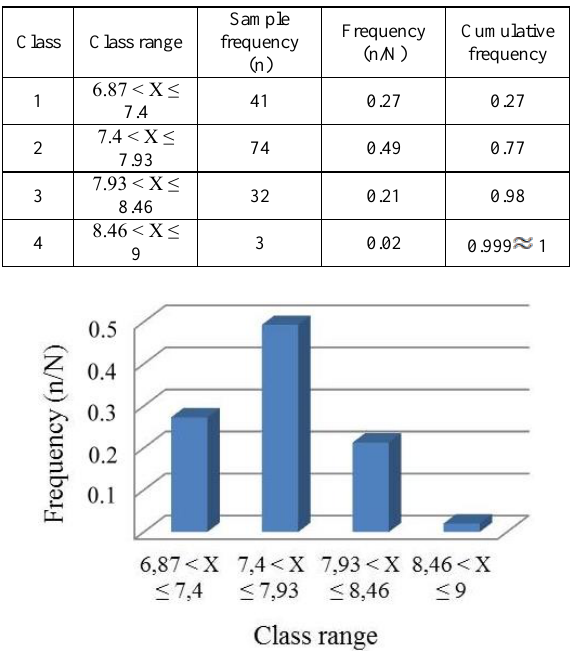
Table 6. Frequency analysis of influent pH values in wastewater